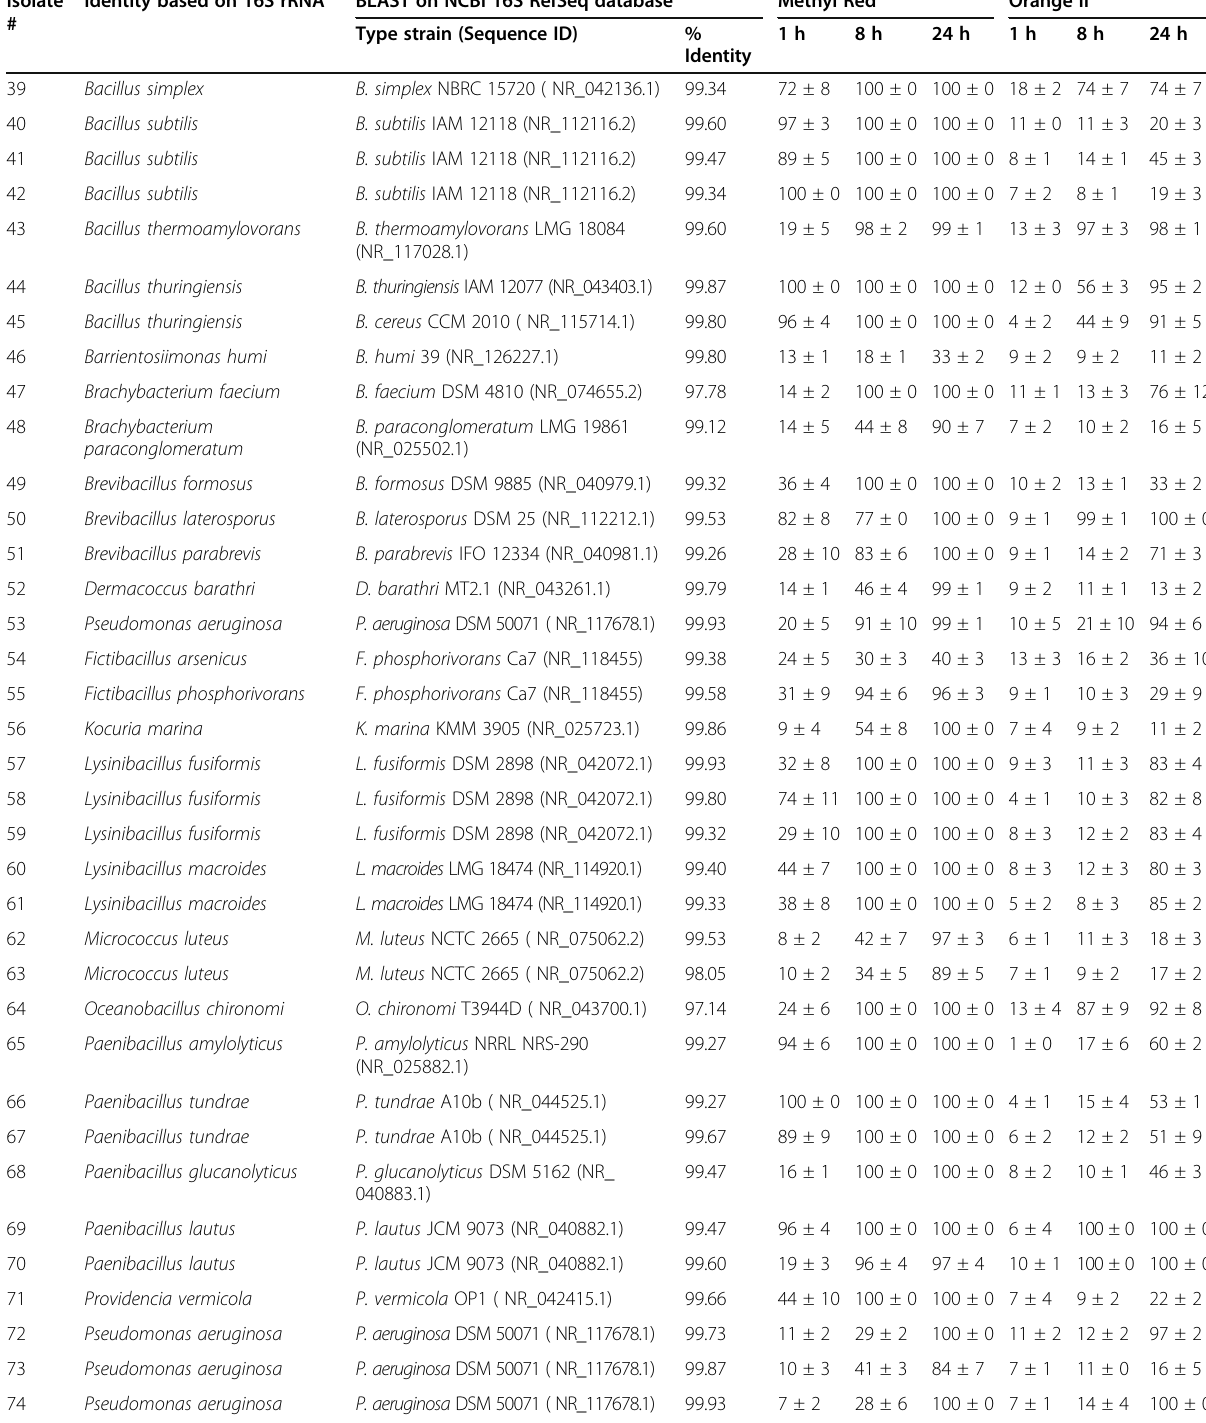
Table 1 Degradation (%)of Methyl Red and Orange II by 79 bacterial isolates a (Continued) Isolate